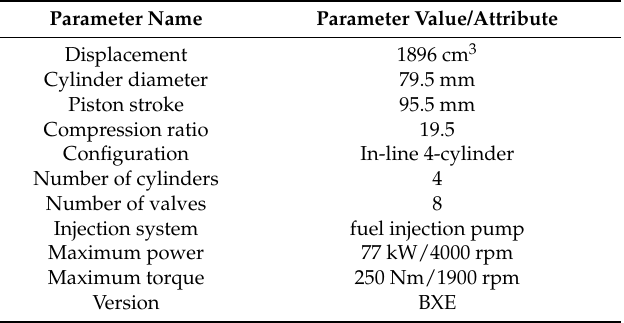
Table 1. The main parameters of the tested engine: 1.9 turbocharged direct injection (TDI) diesel engine with direct injection.